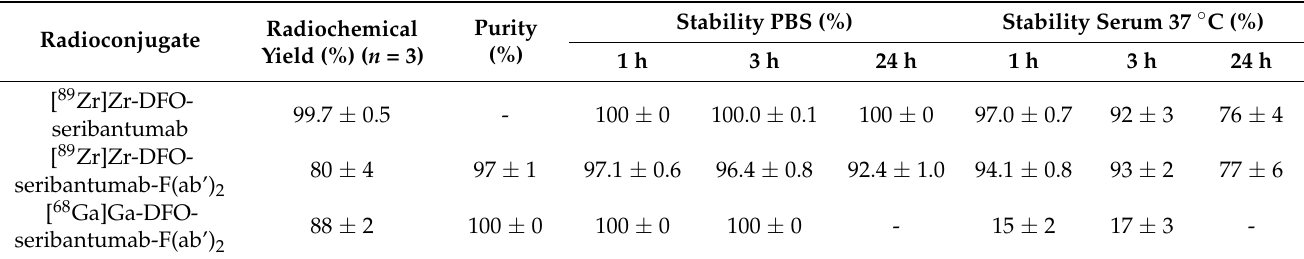
Table 1. Radiochemical yield, purity, and stability of [ 89 Zr]Zr-DFO-seribantumab, [ 89 Zr]Zr-DFO-seribantumab-F(ab’) 2 , and [ 68 Ga]Ga-DFO-seribantumab-F(ab’) 2 determined by radio-iTLC. Stability is expressed as % protein-associated activity. Because of the almost quantitative radiochemical yield, [ 89 Zr]Zr-DFO-seribantumab was used without further purification. Data on the in vitro stability of [ 68 Ga]Ga-Z HER3 was published earlier and can be found in reference [27].